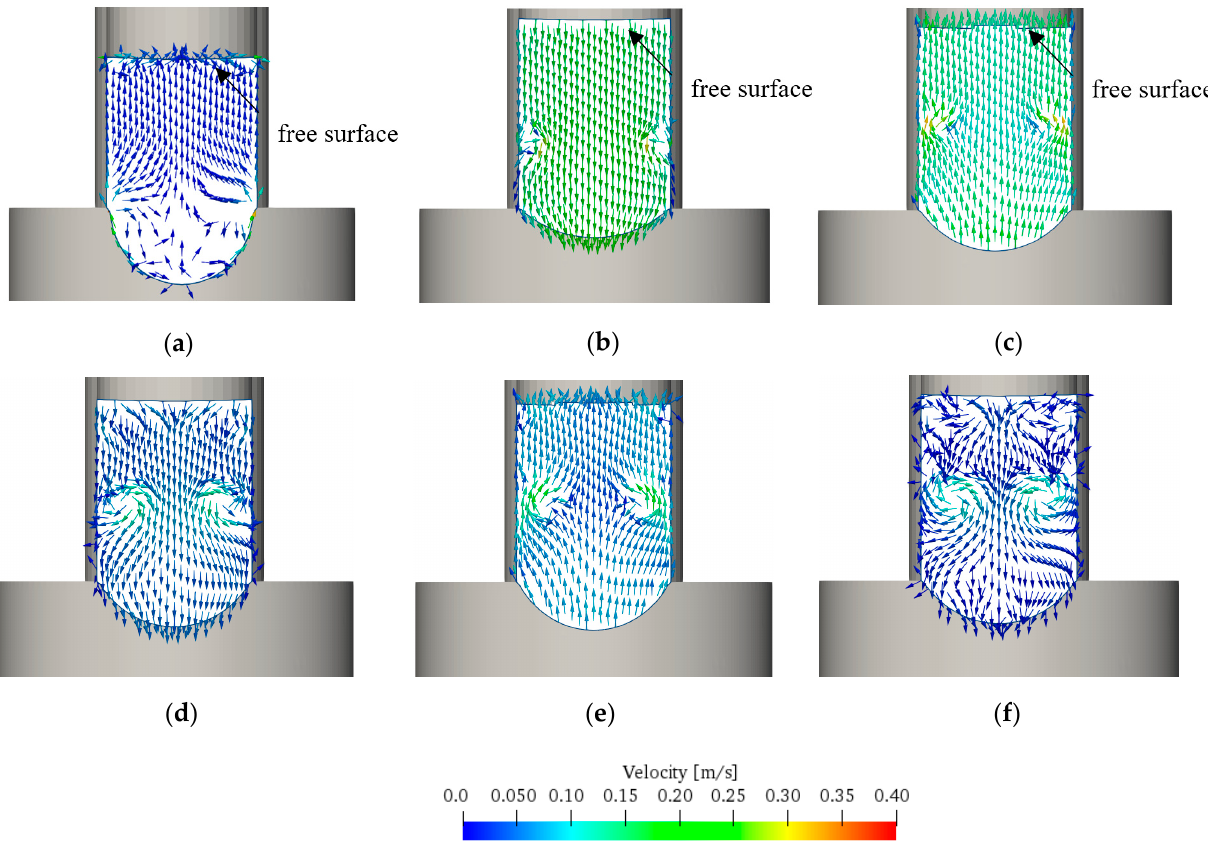
Figure 10. Development of the membrane deformation and the flow velocity vector inside the water chamber with a hyper-elastic material ( d = 0.18 m): ( a ) t = t 1 , ( b ) t = t 2 , ( c ) t = t 3 , ( d ) t = t 4 , ( e ) t = t 5 , and ( f ) t = t 6 .